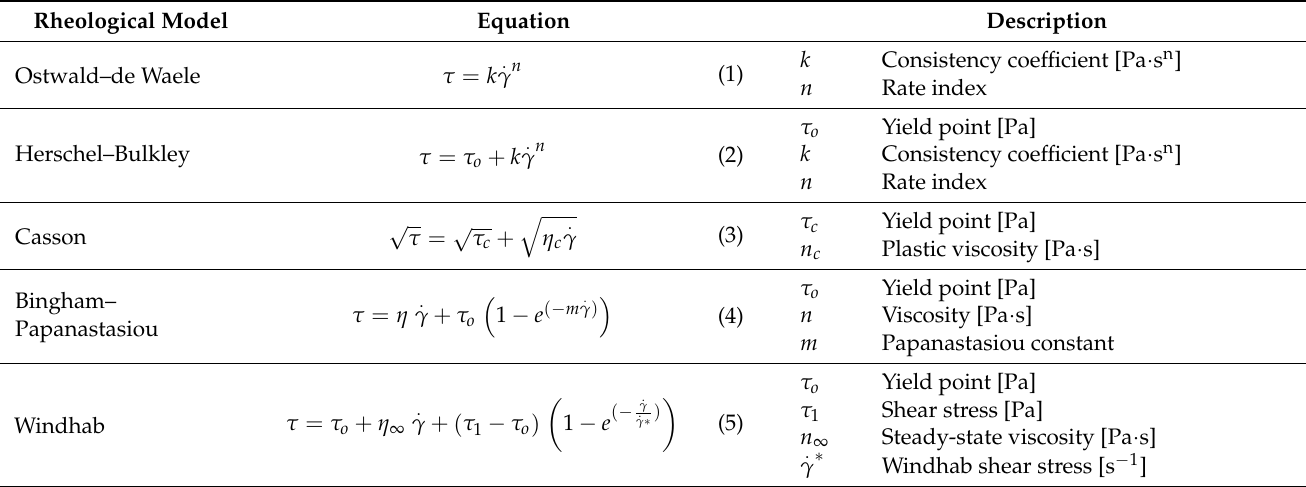
Table 1. Rheological models used to describe hydroxide sludge rheology.